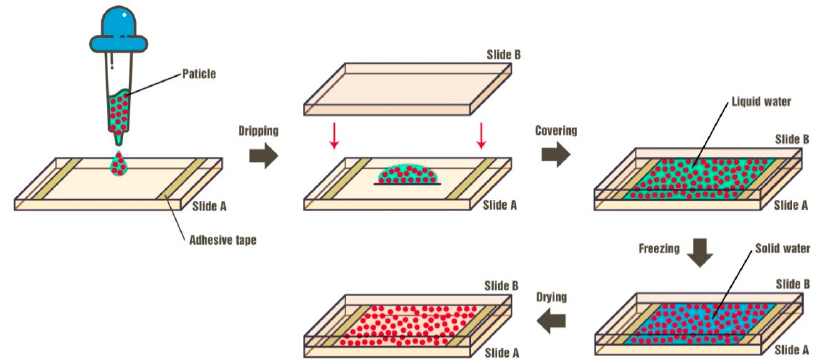
Figure 1. Schematics of the fabrication procedures of colloidal crystal films used for spectral measurement.